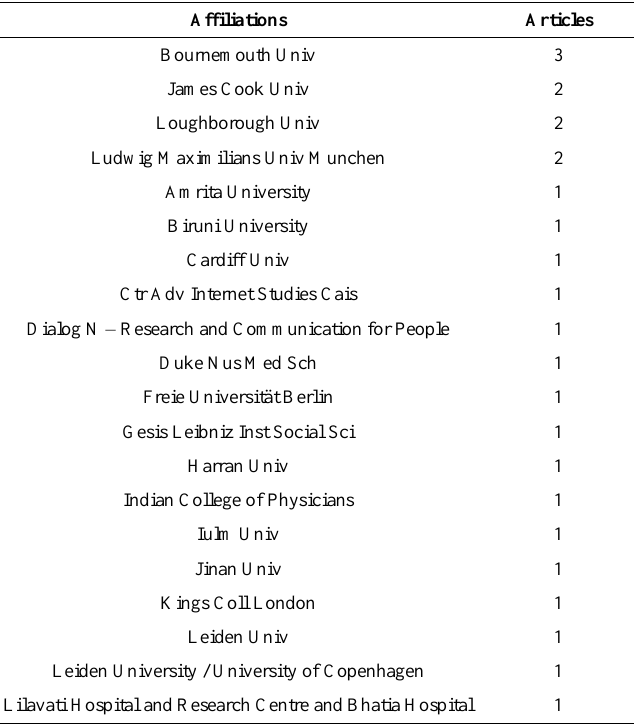
Table 7. Number of affiliations between educational institutions